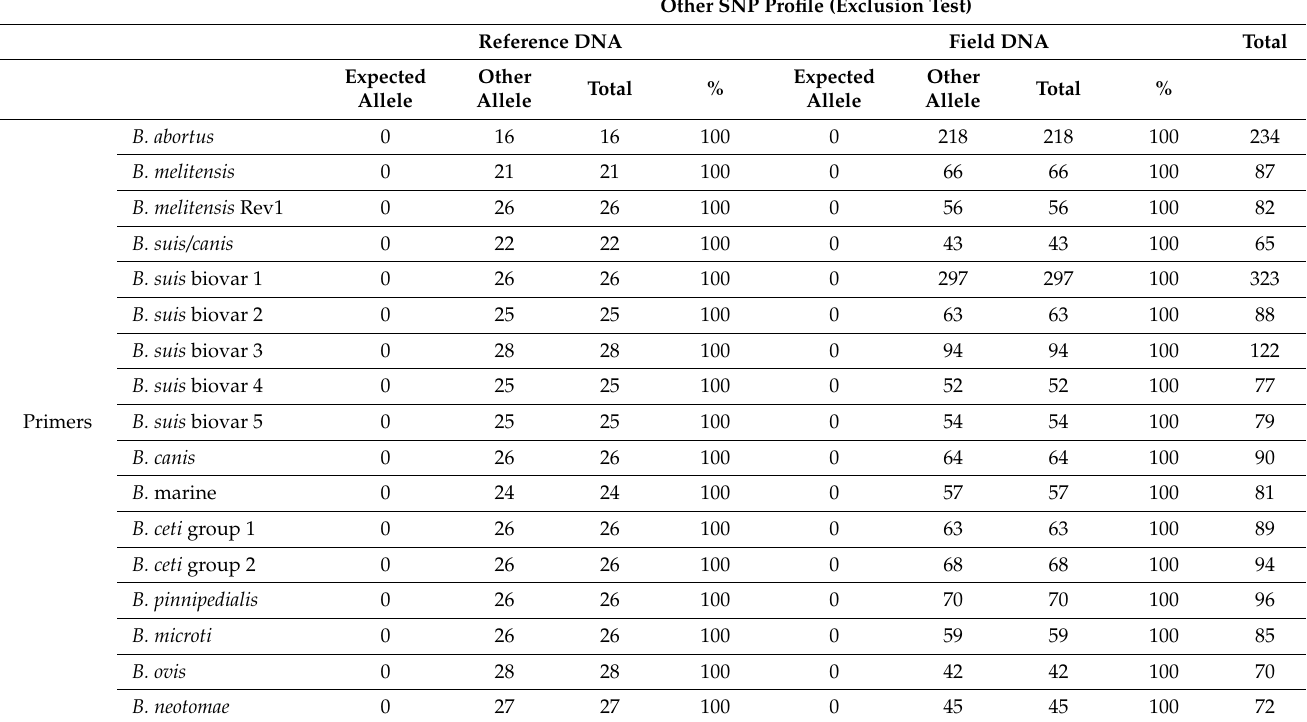
Table 3. Results of exclusivity